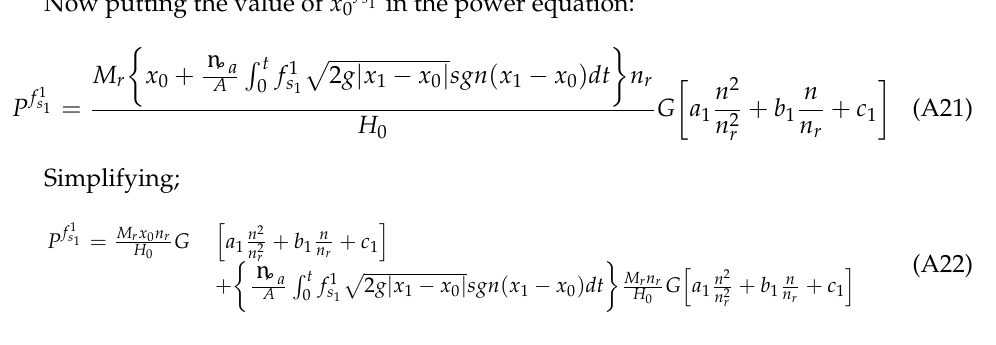
Figure 1. Three-pond hydraulic